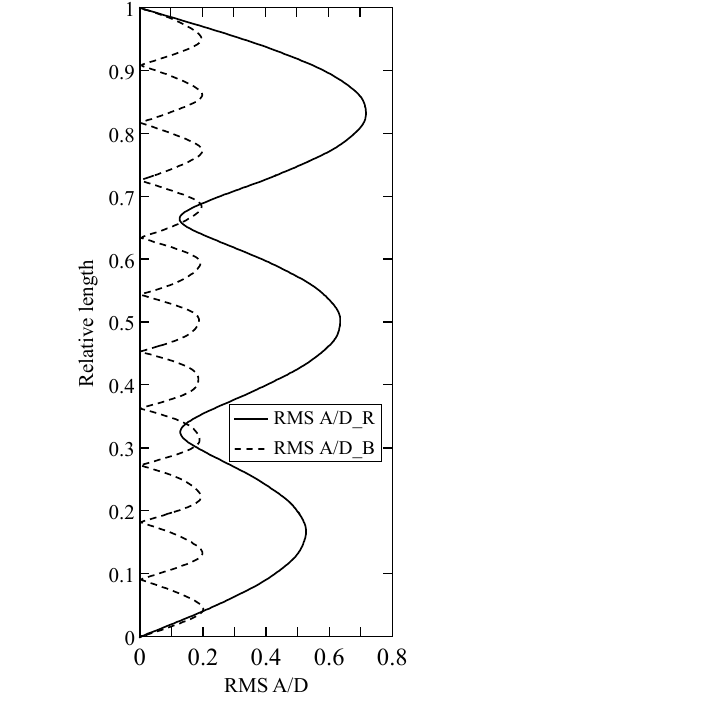
Figure 12. Predicted CF RMS A / D with the obtained optimal parameter set for the 2 / 2 configuration at U = 1.0 m / s. Table 11. Comparison of the prediction and measurements for the 2 / 2 configuration at U = 1.0 m /